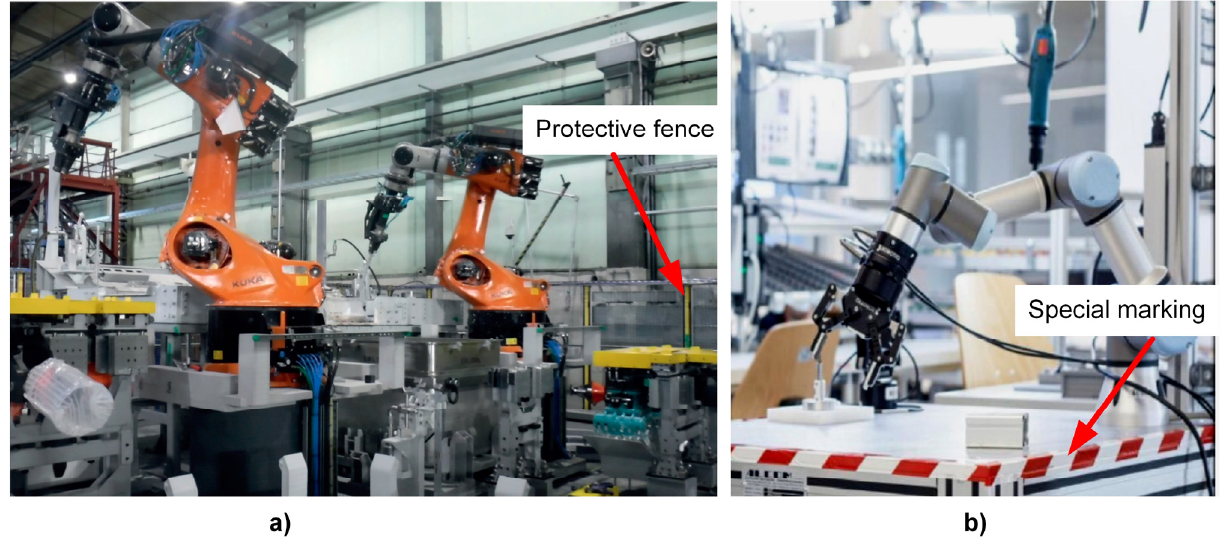
Figure 3. Comparison of the operating environment: ( a ) industrial robots (adapted from [6]); ( b ) collaborative robots (adapted from [7]).